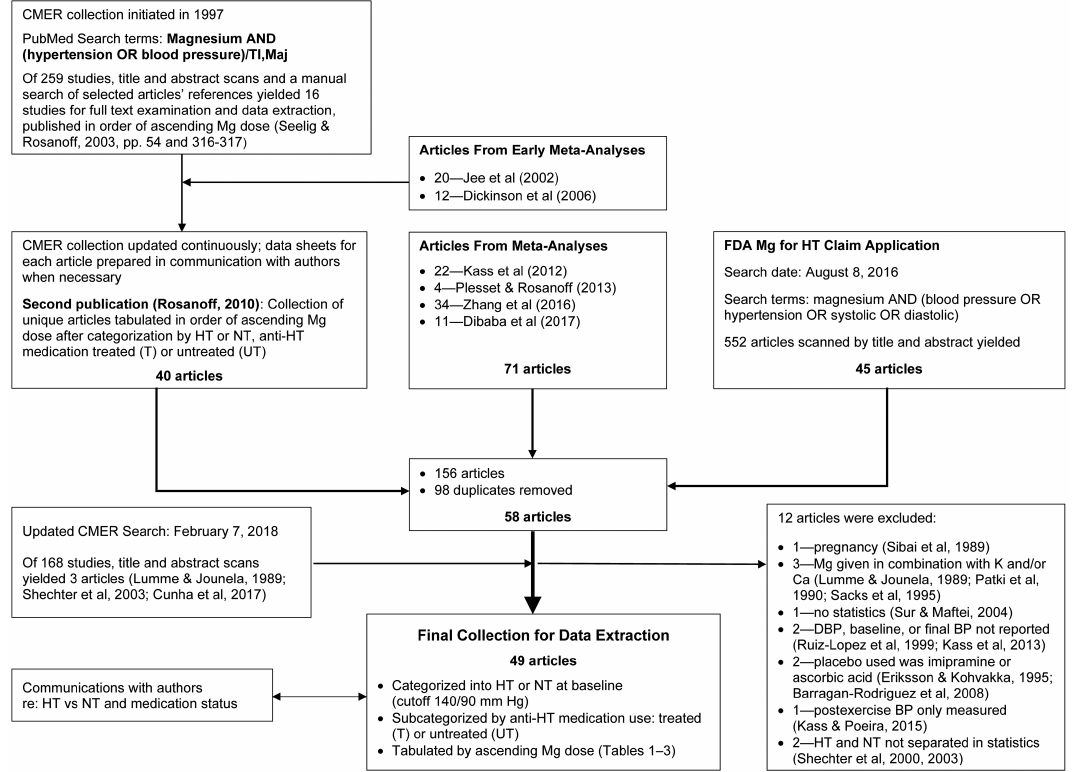
Figure 1. Flow chart of the article acquisition, examination, categorization, and tabulation process. Abbreviations: BP, blood pressure; Ca, calcium; CMER, Center for Magnesium Education & Research; DBP, diastolic blood pressure; HT, hypertensive or hypertension; K, potassium; Maj, Major Topic for National Library of Medicine Pubmed search term; Mg, magnesium; NT, normotensive; T, treated with anti-hypertensive medications; TI, title field for Pubmed search term; UT, untreated, i.e. non-use of anti-hypertensive